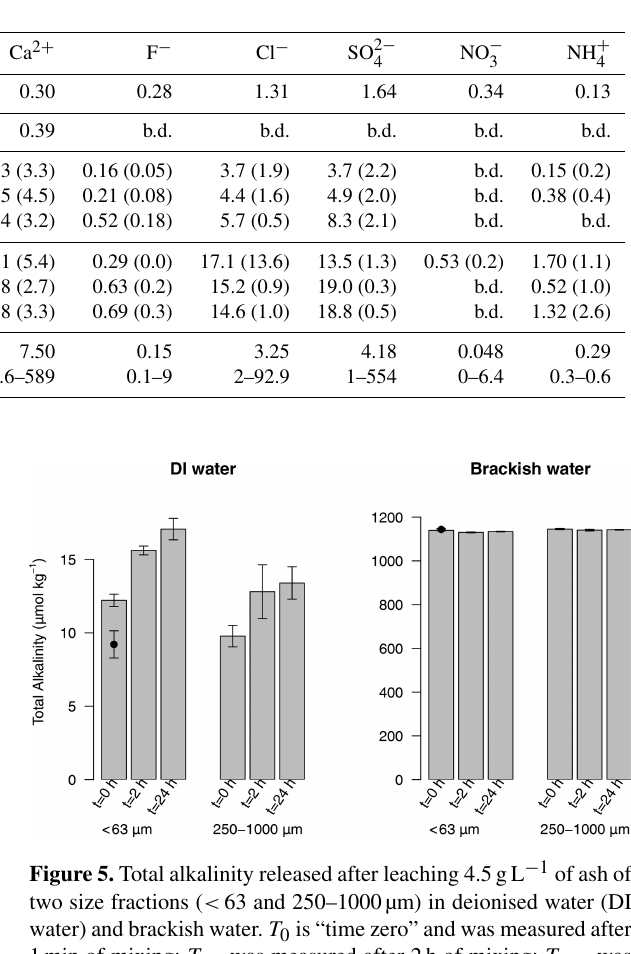
Table 2. Major ion and macronutrient concentrations in micromoles per litre (µmolL − 1 ) leached from the two size fractions of ash ( < 63 and 250–1000µm) into deionised water (b.d. stands for below detection). Shown are mean values, with the standard deviation in parentheses ( n = 4). Also shown are mass normalised values (µmolg − 1 ash) and a comparison to the range of values reported by Jones and Gislason (2008); the latter is referred to as “Range (lit.)” in the table.